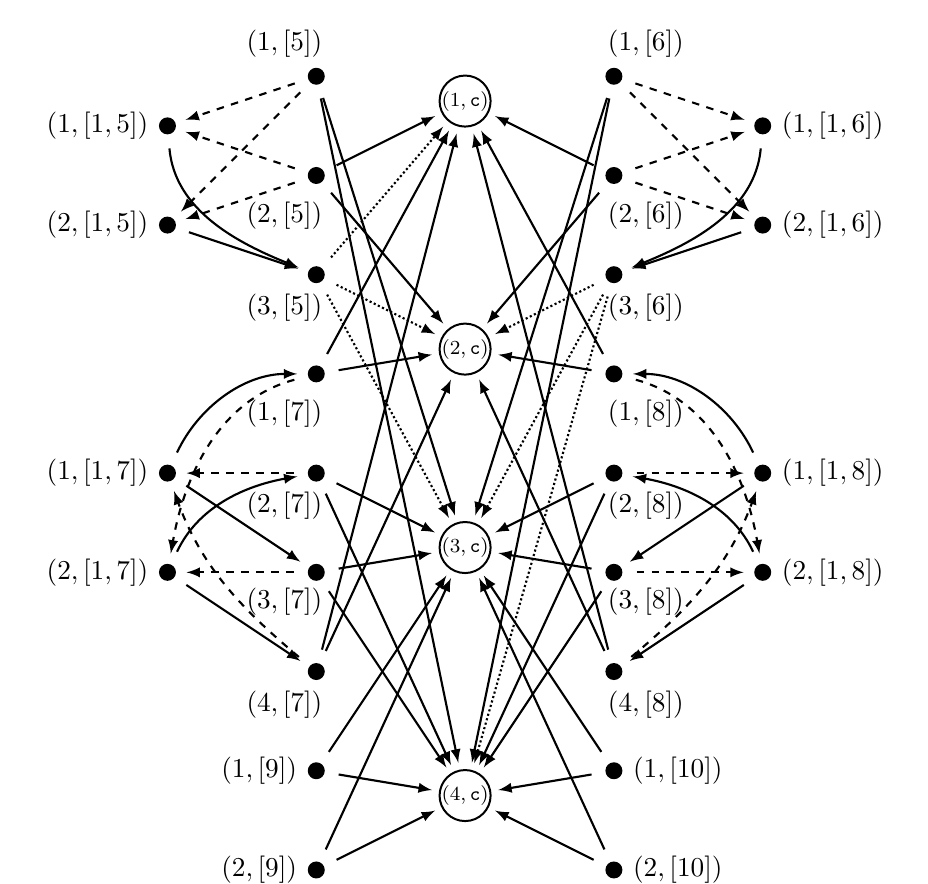
Figure 6: Partial orientation D for H for s =